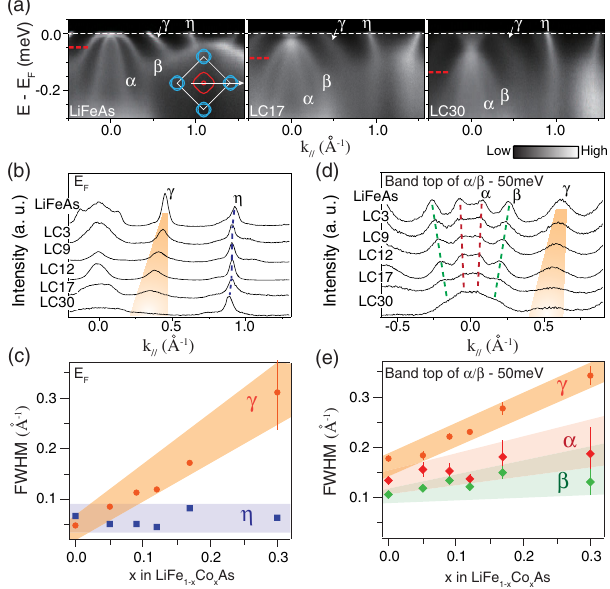
FIG. 1. (a) Doping dependence of the photoemission intensity distribution in LiFe 1 − x Co x As parallel to the Γ -M direction, as indicated by the inset, taken with mixed polarized photons. The red dashed lines illustrate the energy positions of the MDCs in panel (d). (b) Doping dependence of the MDCs at E F . Panel (c) shows the corresponding FWHMs of γ and η in panel (b). (d) MDCs at 50 meV below the band tops of α and β as a function of doping, since α and β do not cross E F . Panel (e) is the corresponding FWHMs of α , β , and γ in panel (d). The error bars of FWHM in panels (c) and (e) are standard deviations of the Lorentzian fit to MDC